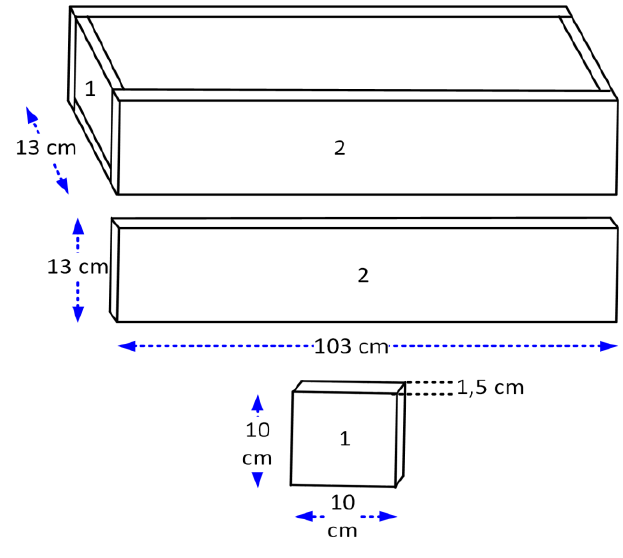
Fig.3. Grounding system mold